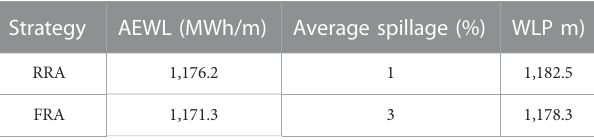
TABLE 6 Performance comparison of TVRRA and FRA.